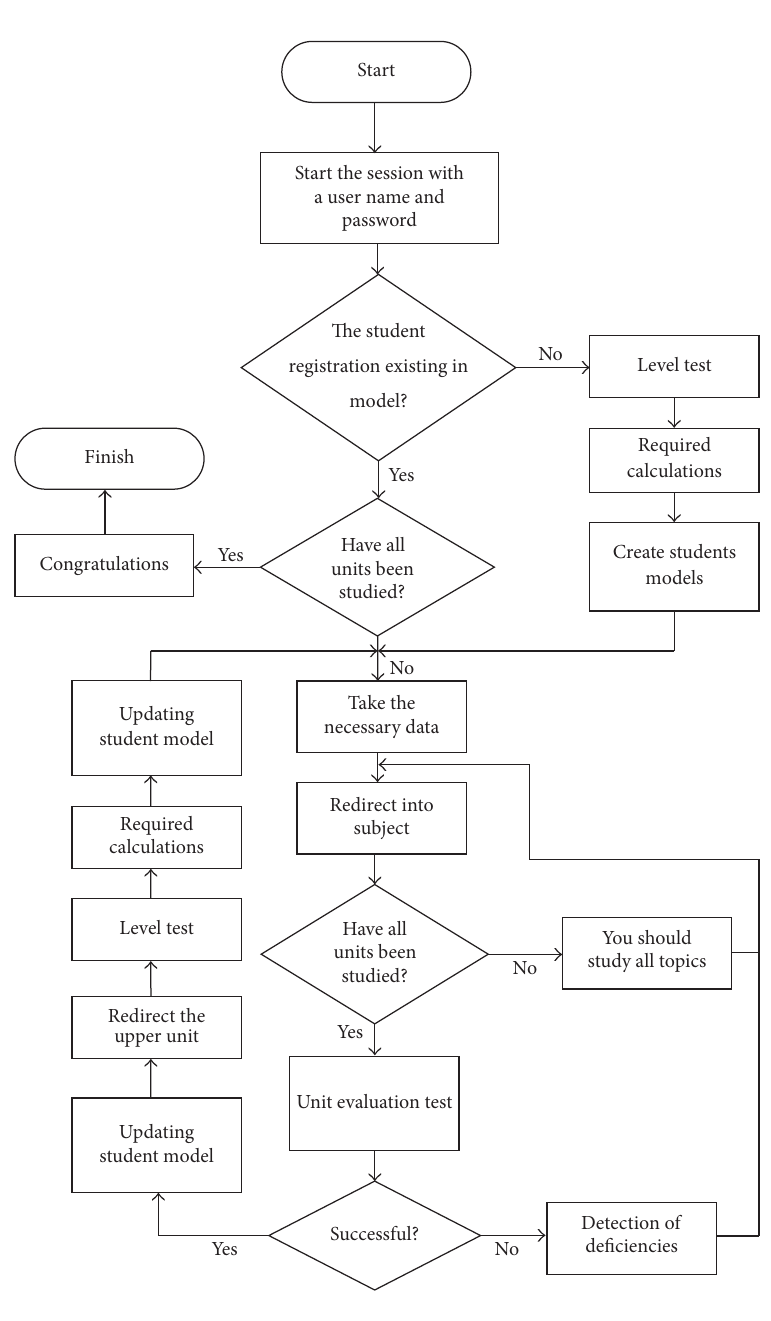
Figure 2: Students’ model